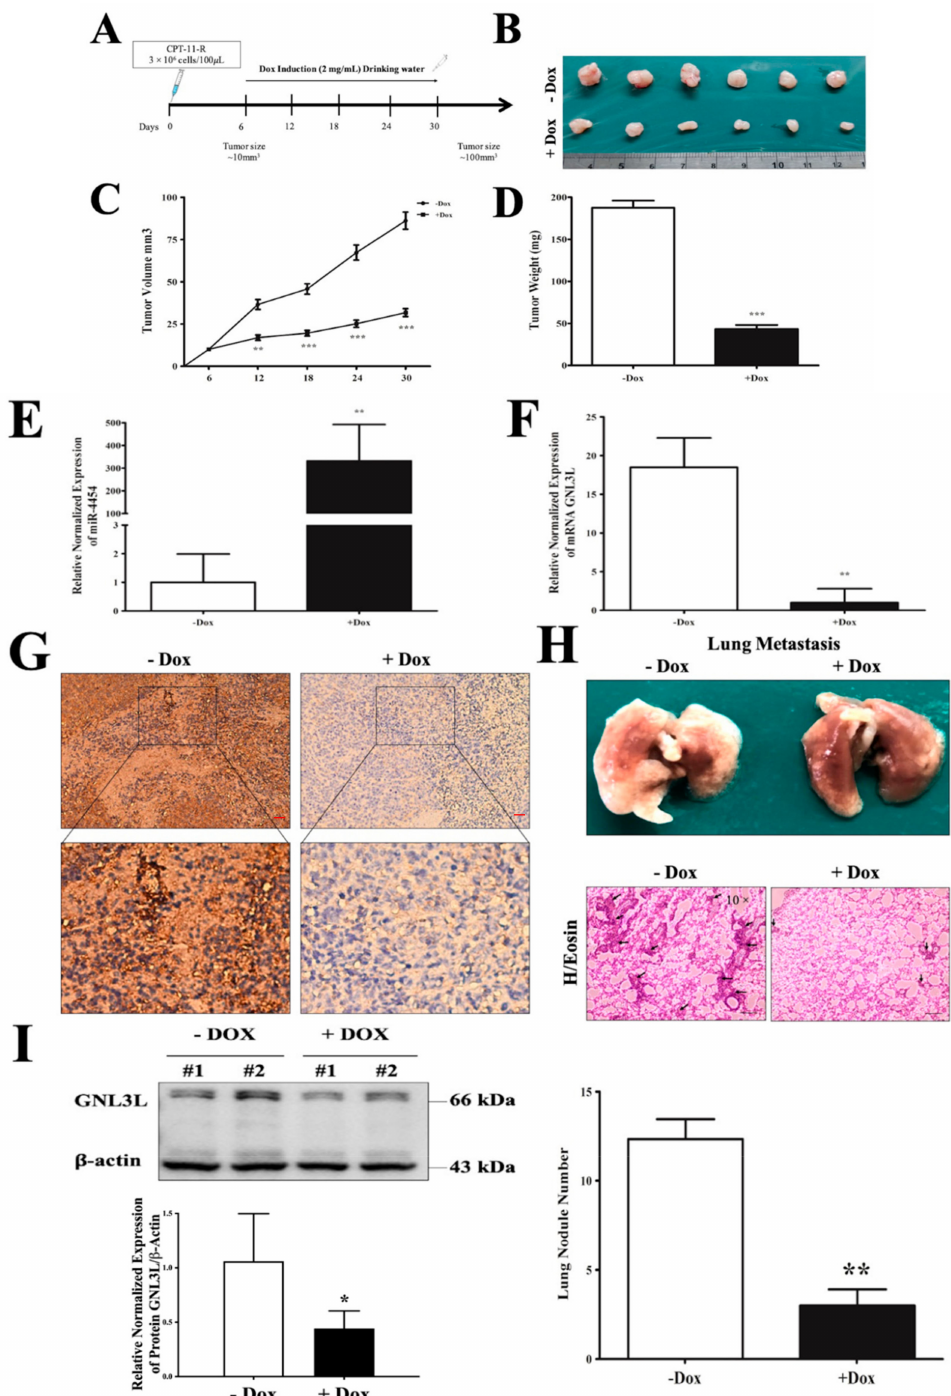
Figure 8. Doxycycline-induced expression of miR-4454 suppresses colon cancer growth. ( A ) Schematic overview of the doxycycline-inducible miR-4454 expression in mice and the tumor suppression e ff ect of the resistant colon cancer cells injected subcutaneously in nude mice. ( B , C ) Tumor volume measurements (mm 3 ). ( D ) Tumor weight measurement (mg). ( E ) − Dox or + Dox tumor miR-4454 expression level and ( F ) GNL3L expression level. ( G ) IHC analysis of GNL3L protein expression level (scale bar: 50 µ m). ( H ) Lung metastasis node formation morphology and hematoxylin and eosin stain (the arrow represents the node tumors formed). ( I ) Western blot analysis of GNL3L expression level. The results are presented as mean ± standard error of the mean ( n = 3). * p < 0.05, ** p < 0.01, *** p < 0.001 compared to